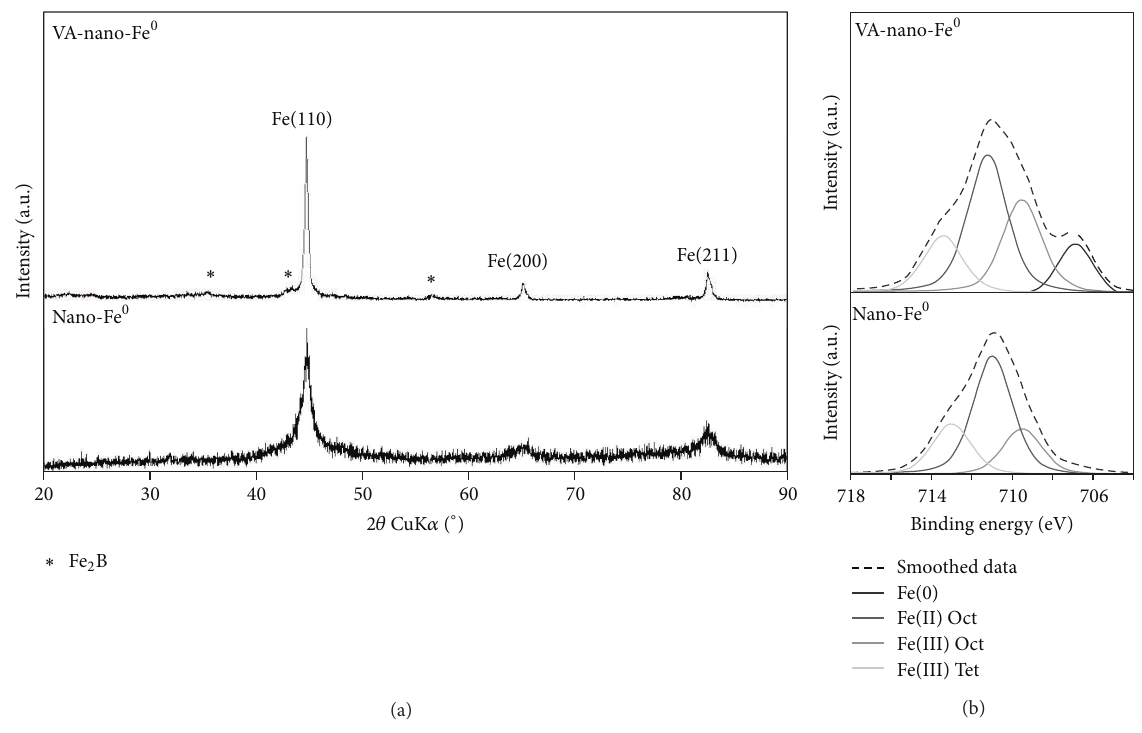
Figure 2: (a) X-ray diffraction (XRD) spectra acquired for nano-Fe 0 and VA-nano-Fe 0 for the range 20–90 ∘ 2 𝜃 . (b) X-ray photoelectron spectroscopy (XPS) Fe 2p 3/2 photoelectron peaks for nano-Fe 0 and VA-nano-Fe 0